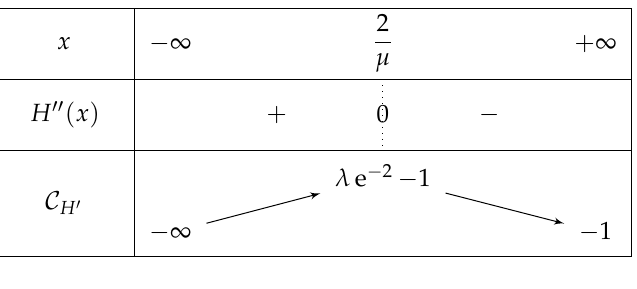
Figure 4. Variations for H (cid:48)